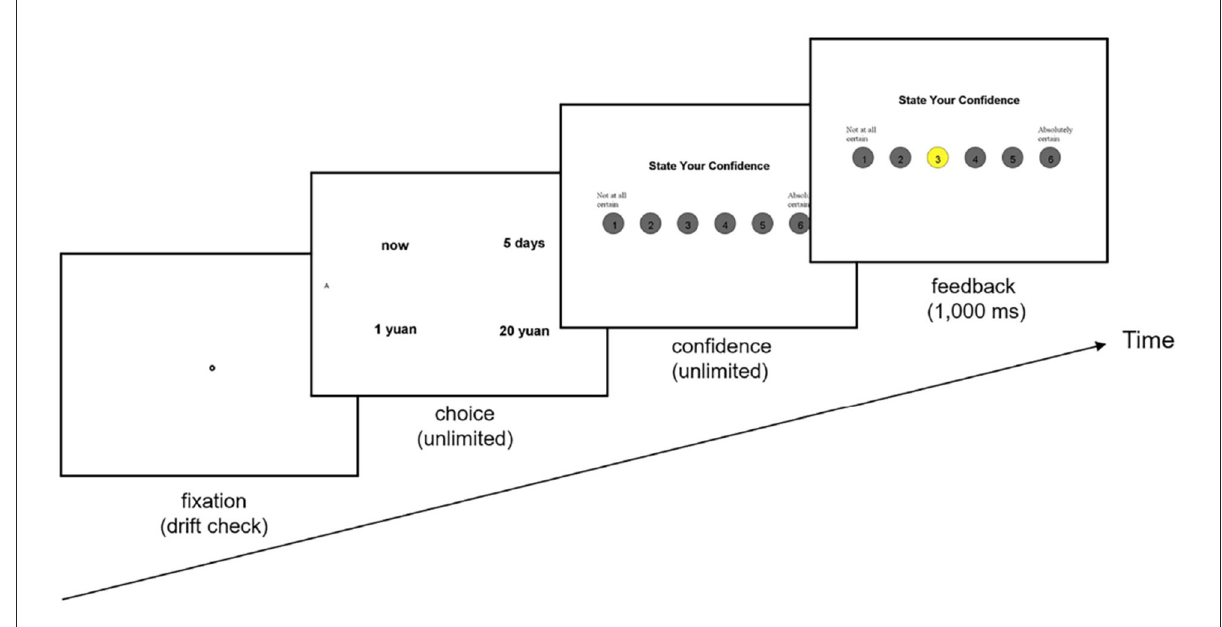
FIGURE1 Trial procedure and timing in the